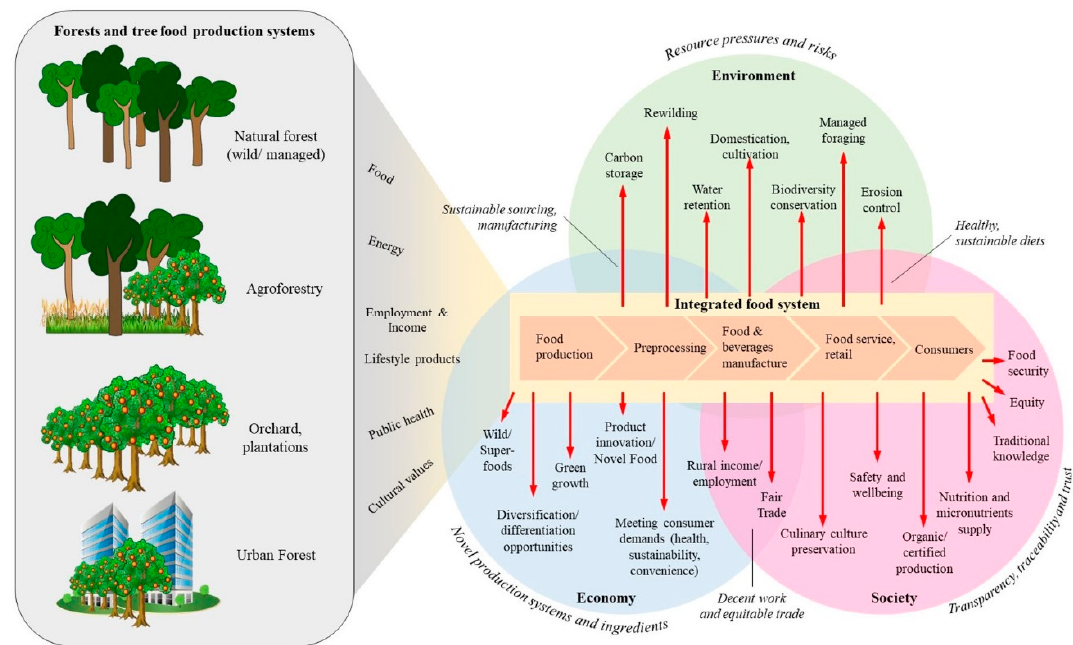
Figure 2. Integration of forests and trees into food systems has many elements that lead to a framework for transitioning to a bioeconomy. Source: modified from food system framework as presented by the Institute of Food Science and Technology [118].